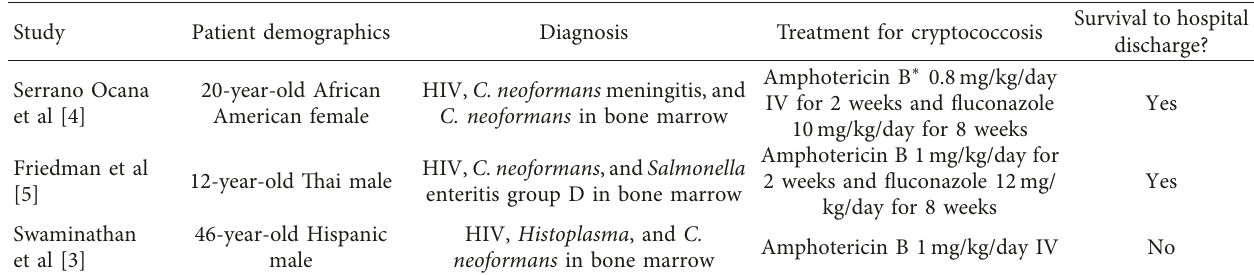
Table 1: Reported treatments for C. neoformans infection in the bone marrow of HIV